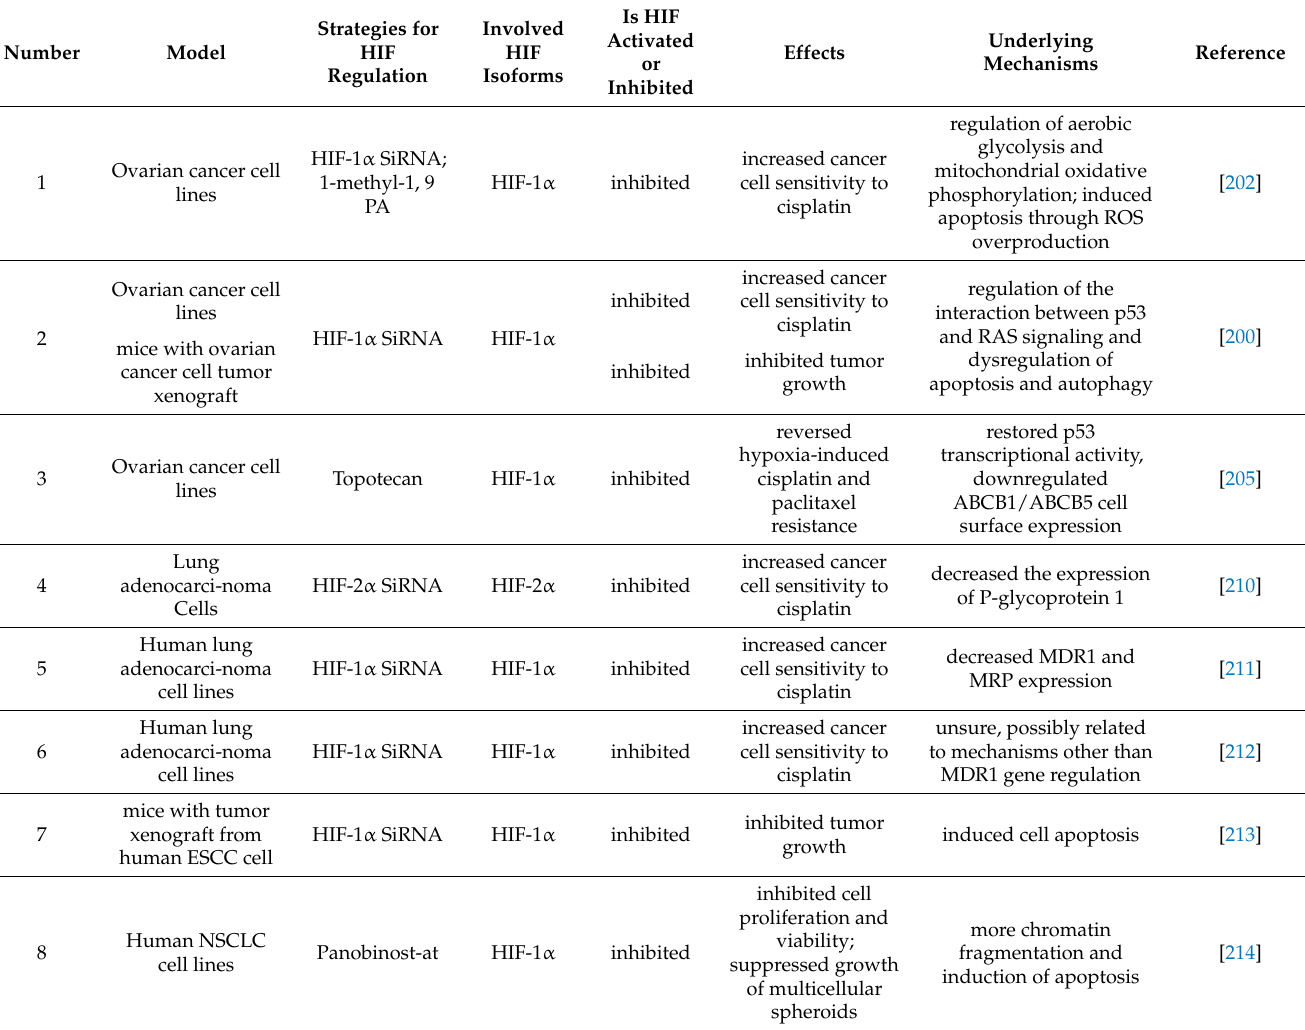
Table 2. Summary of studies about therapeutic potential of HIF in cisplatin